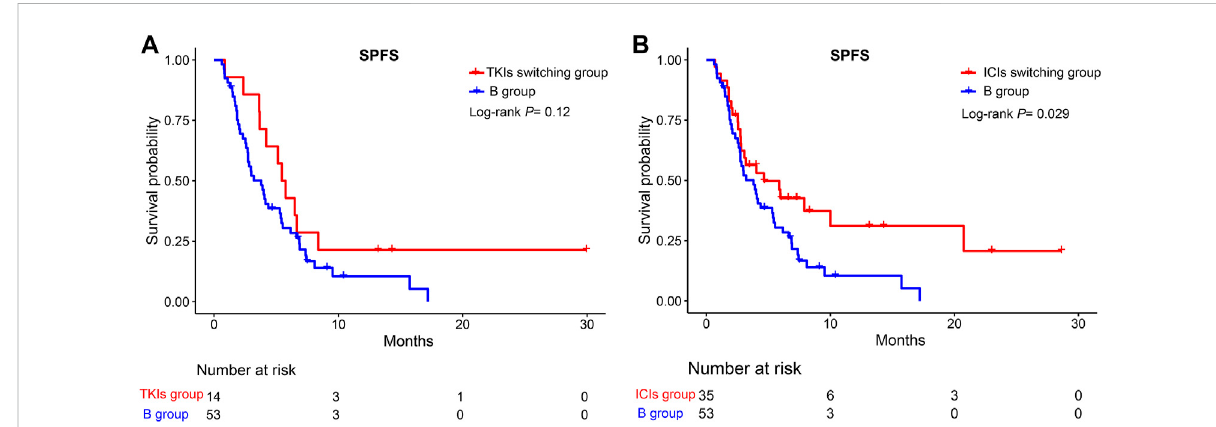
FIGURE 5 Kaplan-Meier curves for SPFS of patients in the TKIs switching group, ICIs switching group, and the B group. (A) TKIs switching group vs. B group; (B) ICIs switching group vs. B group. SPFS, second progression-free survival; TKIs, tyrosine kinase inhibitors; ICIs, immune checkpoint inhibitors.